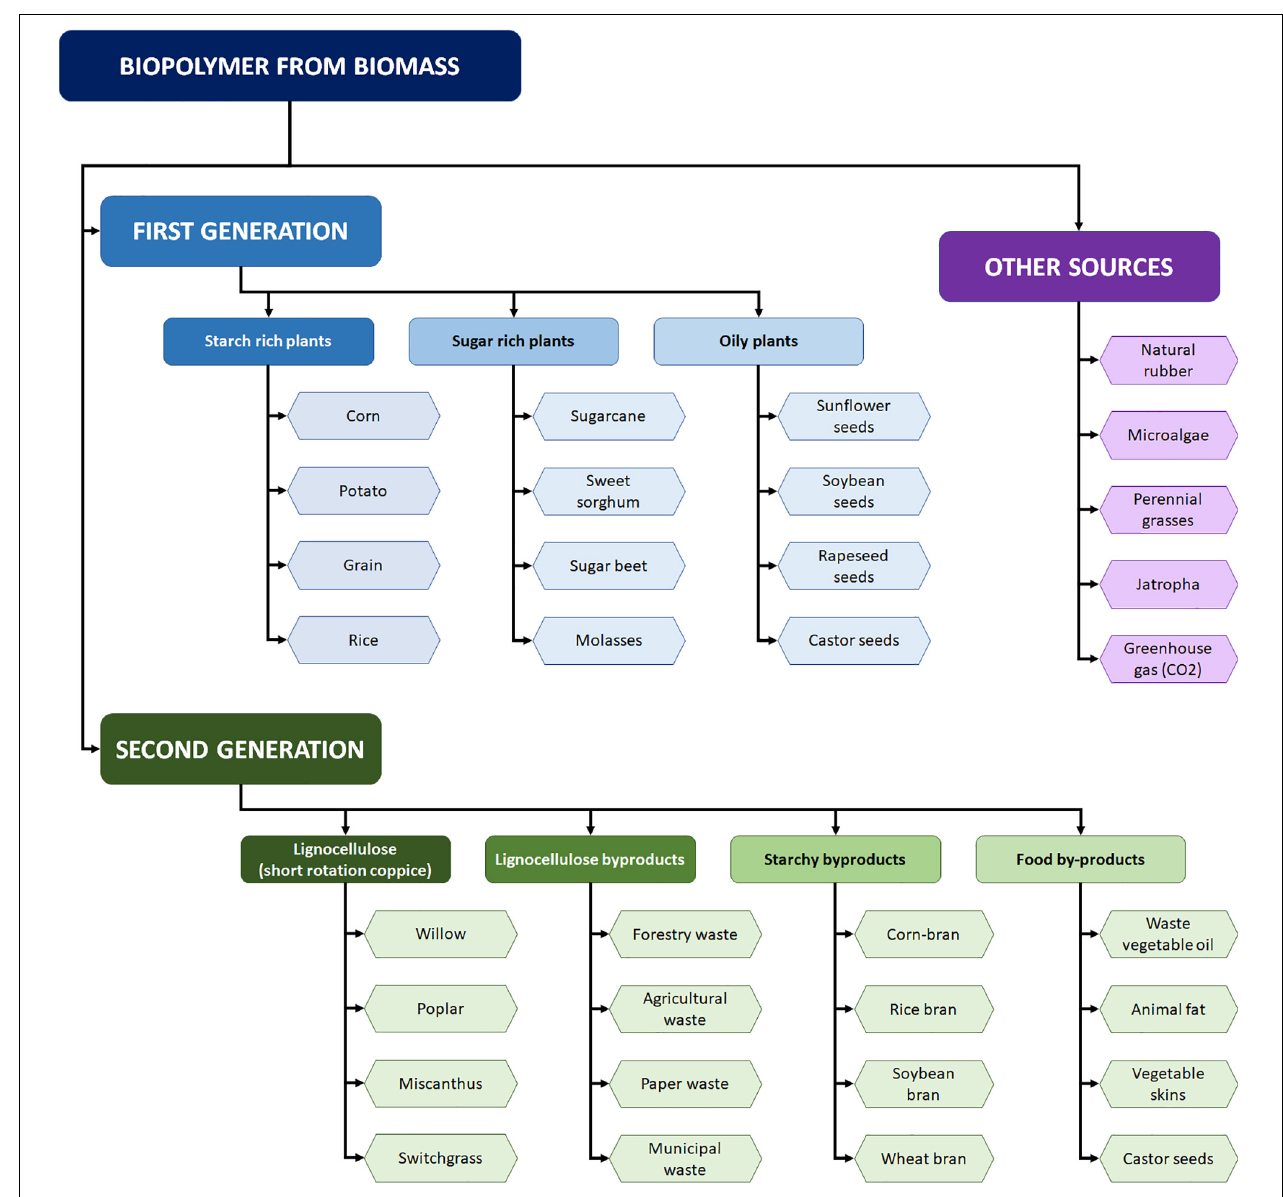
FIGURE 1 | Application of agroindustrial byproducts for the generation of biobased